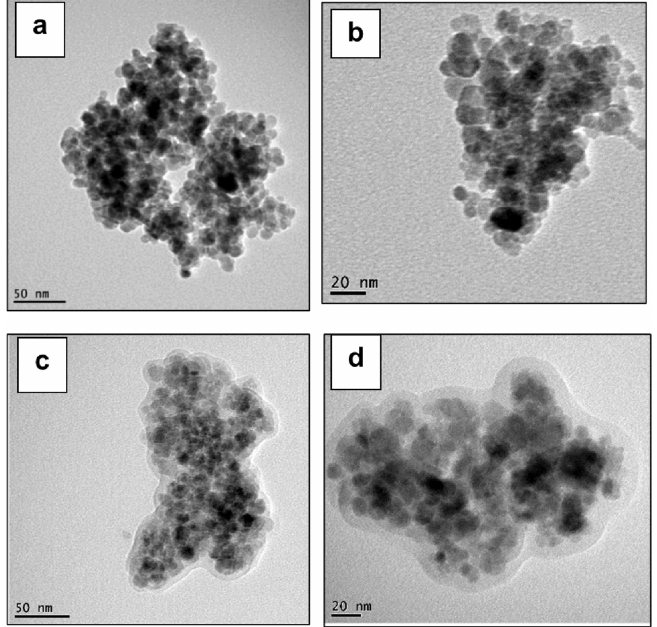
Figure 3. ( a – d ) TEM pictures of untreated magnetite NPs ( a , b ) and NPs surface treated with MHX ( c , d ).